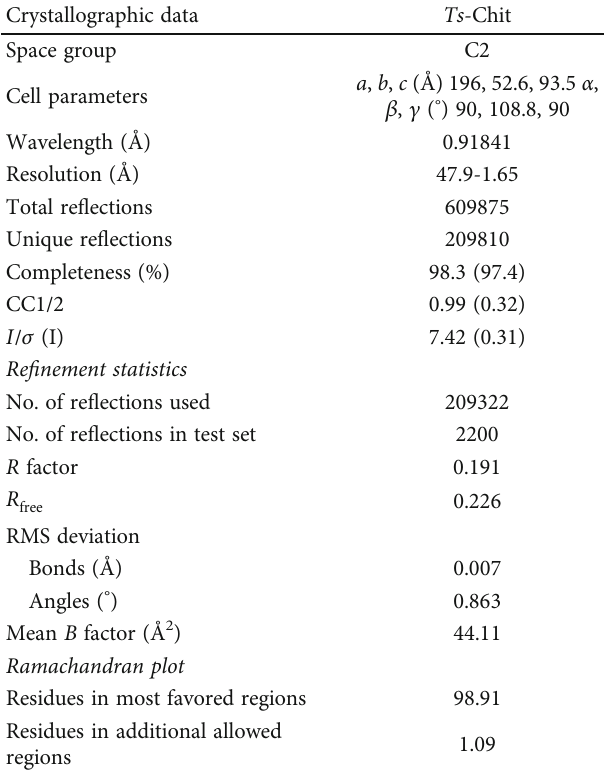
Table 3: X-ray-based structure analysis data collection and re fi nement